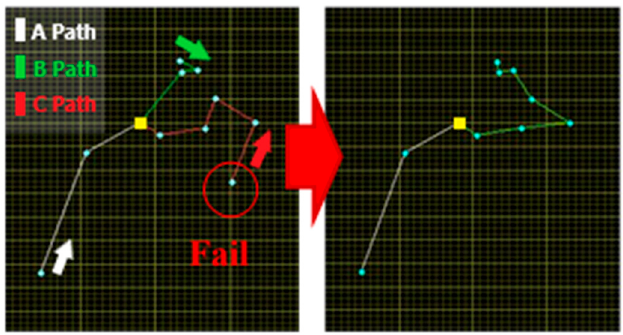
Figure 17. C path fail occurred ( Left ), and a new optimum path generated for covering remaining target ( Right ).